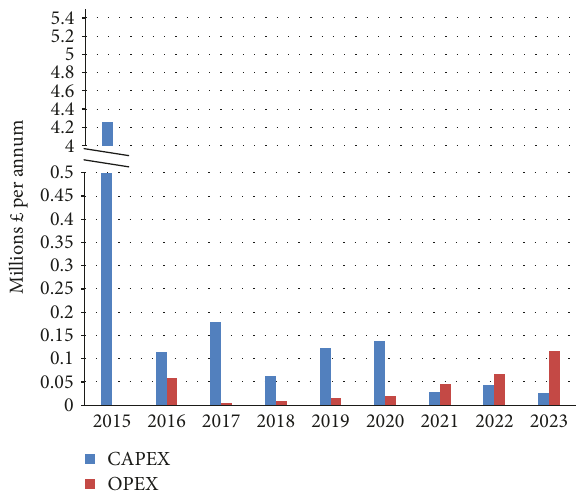
Figure 9: CAPEX and OPEX; DECC4, 2015 – 2023.